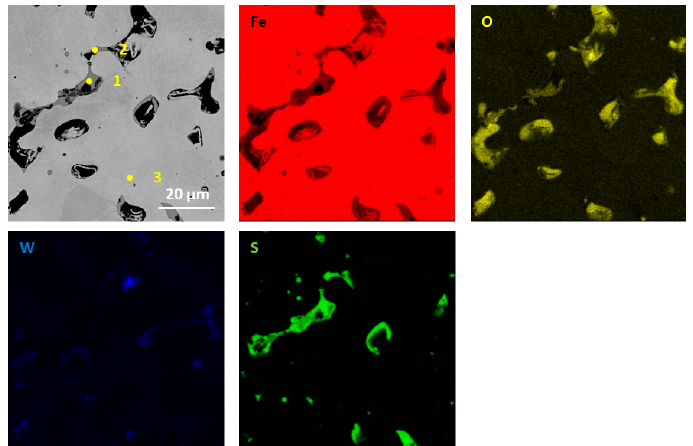
Figure 9. EDS mapping of sintered Fe with the addition of WS 2 with a size of 0.6 μ m (for pressing pressure 350 MPa) together with point analysis.